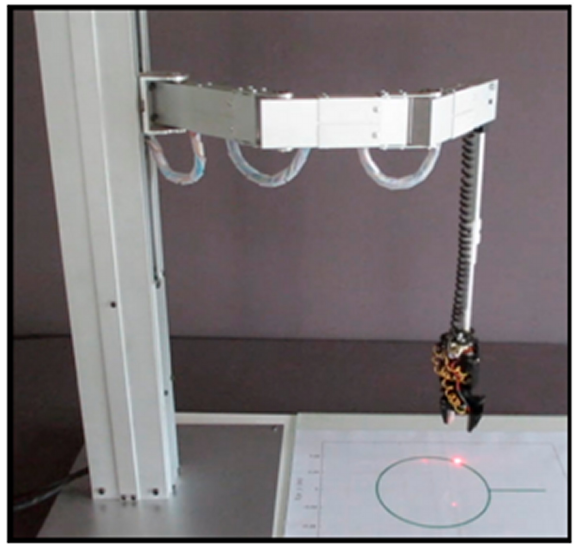
Figure 13. Real redundant planar manipulator